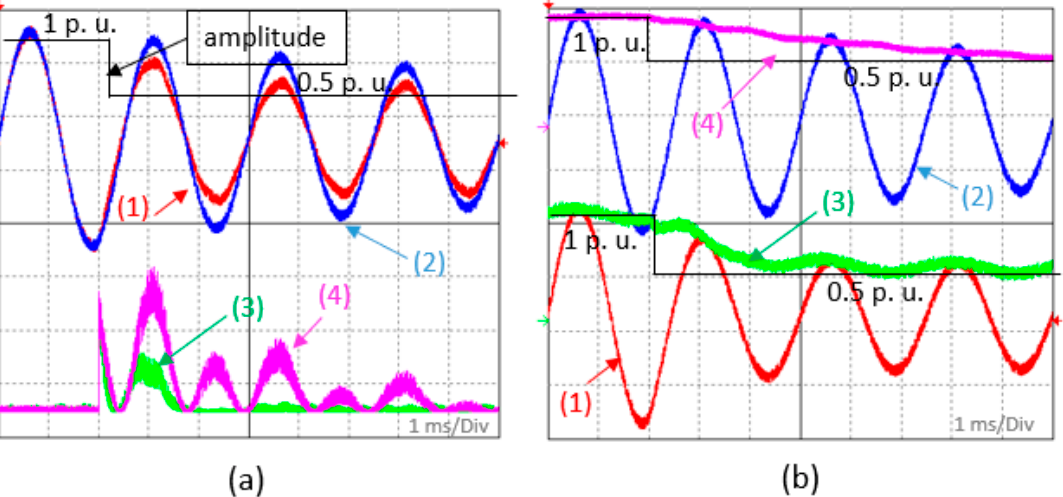
Figure 14. Dynamic performance of the proposed method compared to the EPLL method for amplitude jump down of 50%: ( a ) recorded signals of (1) estimated fundamental waveform for the FLC method, (2) estimated fundamental waveform for the EPLL, (3) estimation error for the proposed method and (4) estimation error for the EPLL; ( b ) recorded signals of (1) estimated fundamental waveform for the FLC method, (2) estimated fundamental waveform for the EPLL, (3) estimation error for the proposed method and (4) estimation error for the EPLL.